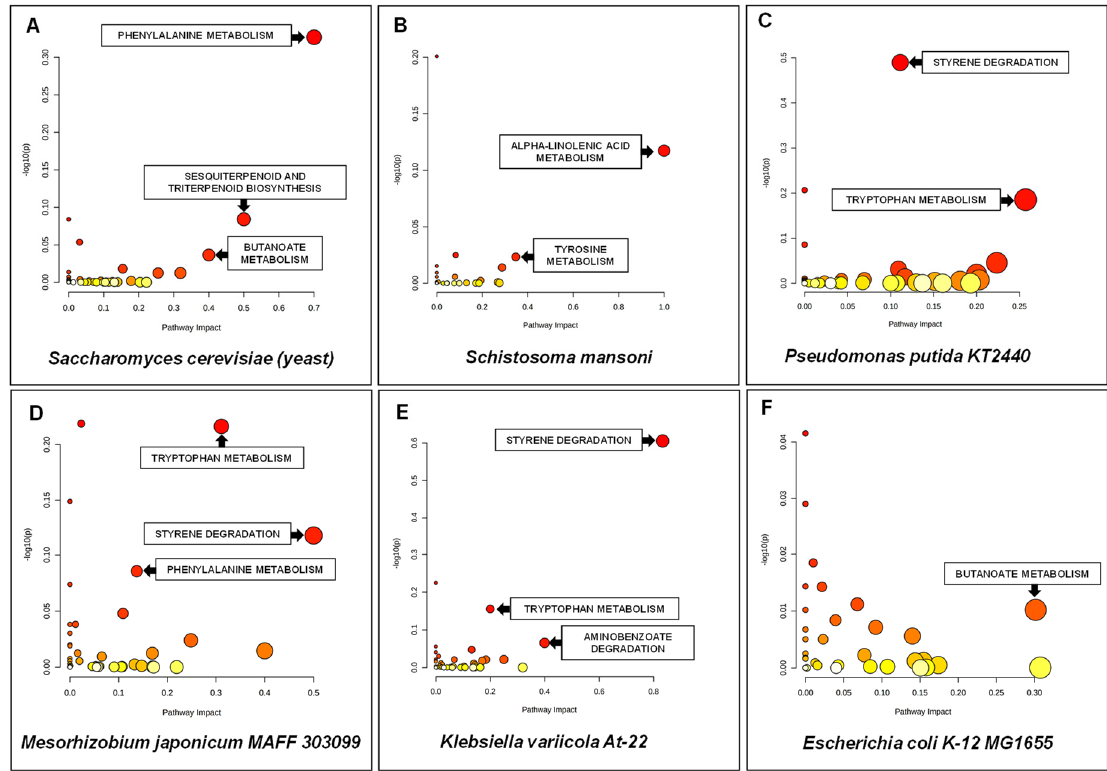
Figure 14. Summary of pathway analysis for leachate samples. All matched pathways are displayed as circles. The colour and size of each circle are based on the p -value and pathway impact value. Metabolites from: ( A ) Saccharomyces cerevisiae ; ( B ) Schistosoma mansoni ; ( C ) Pseudomonas putida ; KT2440; ( D ) Mesorhizobium japonicum MAFF 303099; ( E ) Klebsiella variicola At-22; ( F ) Escherichia coli K-12 MG1655.